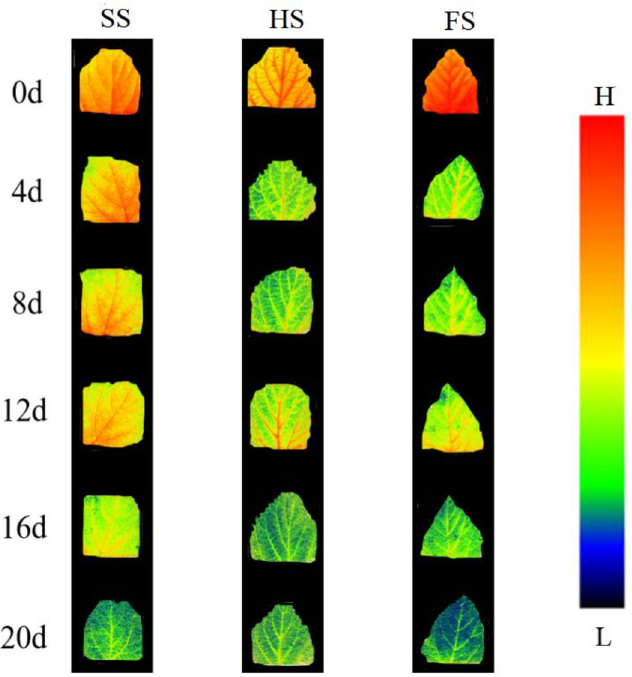
Figure 5. Fliorescence imaging showing the effect of submergence stress on QY_max values in Morus alba. The figure was drawn using Photoshop CS6 V13.0.